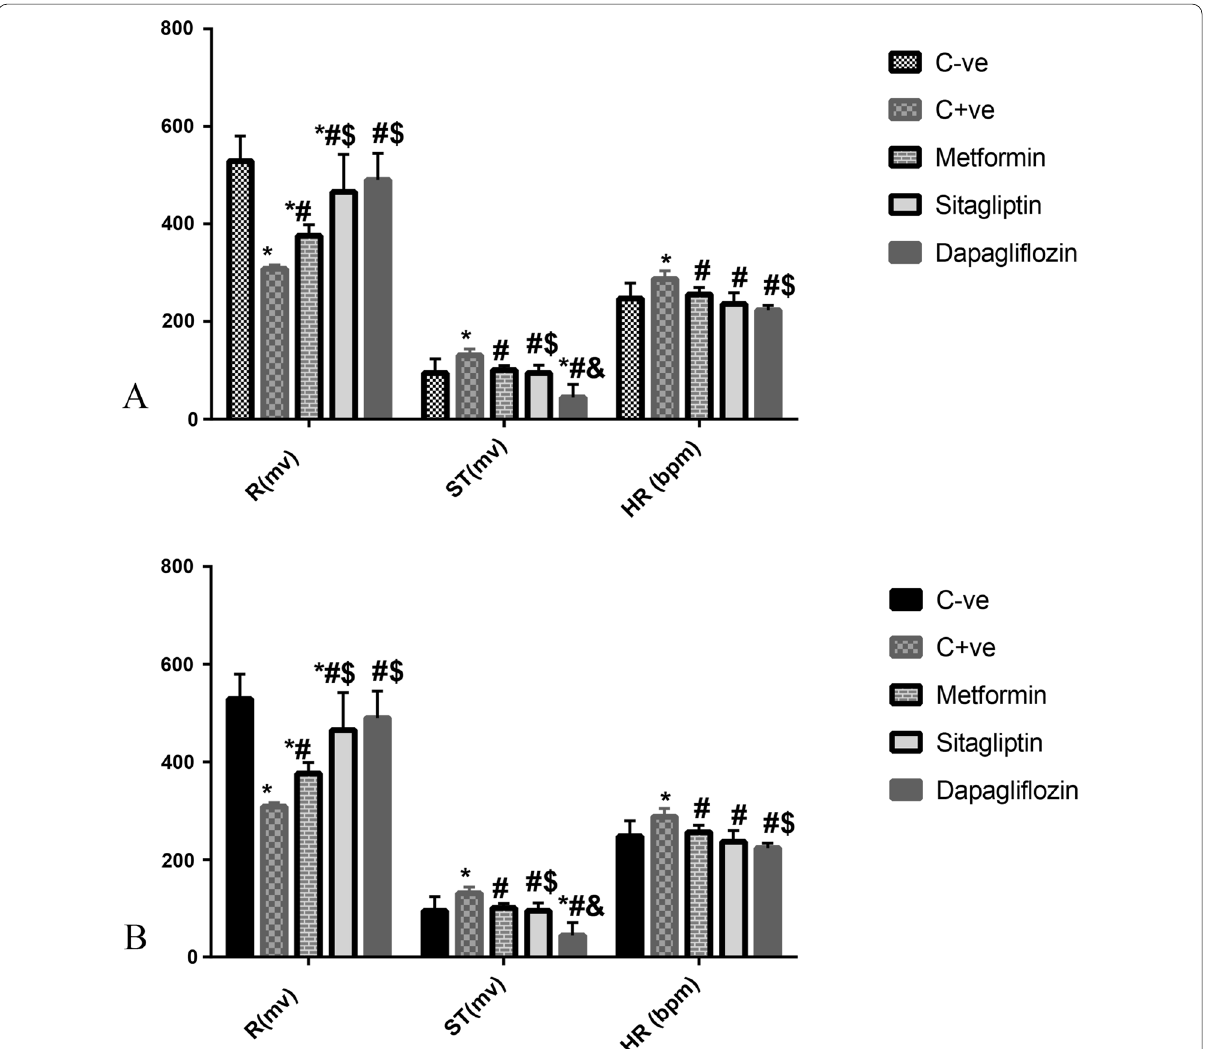
Fig. 3 ECG parameters among different studied groups *: Significant between normal control and each other group, #: Significant between C and each other group, $: Significant between Metformin and each other group and &: Significant between Sitagliptin and